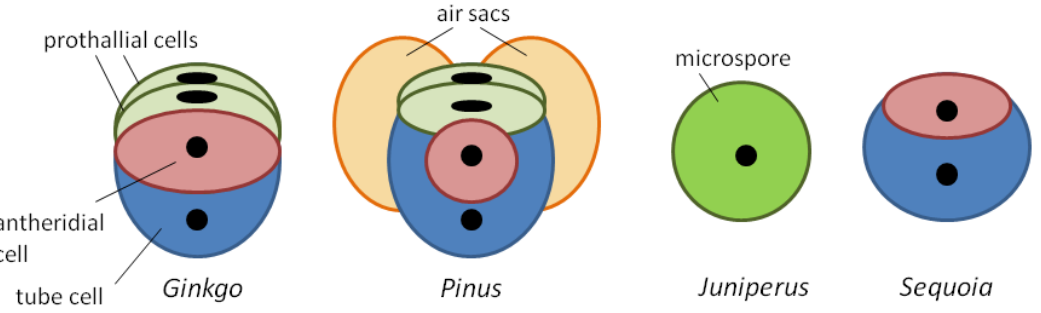
Figure 1. Cellular composition of some gymnosperm pollen grains at dehiscence.